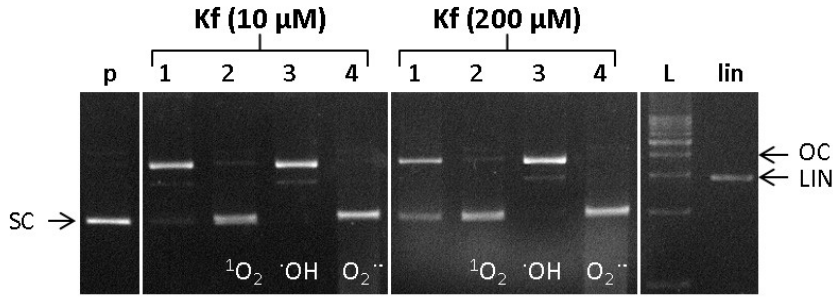
Figure 9. Electrophoretic profiles of agarose gel (0.8%) containing 15 μ mol plasmid DNA pBSK+ with Cu(II) ions and hydrogen peroxide, to which 10 μ mol and 200 μ mol of kaempferol had been added, respectively. Samples were loaded in the gel lanes in the following order: (p) pDNA ‐ control; Left panel: (1) pDNA + 5 μ M CuCl 2 + 50 μ M H 2 O 2 + 10 μ M kaempferol, (2) pDNA + 5 μ M CuCl 2 + 50 μ M H 2 O 2 + 10 μ M kaempferol + L ‐ histidine; (3) pDNA + 5 μ M CuCl 2 + 50 μ M H 2 O 2 + 10 μ M kaempferol + DMSO; (4) pDNA + 5 μ M CuCl 2 + 50 μ M H 2 O 2 + 10 μ M kaempferol + SOD; Right panel: (1) pDNA + 5 μ M CuCl 2 + 50 μ M H 2 O 2 + 200 μ M kaempferol; (2) pDNA + 5 μ M CuCl 2 +